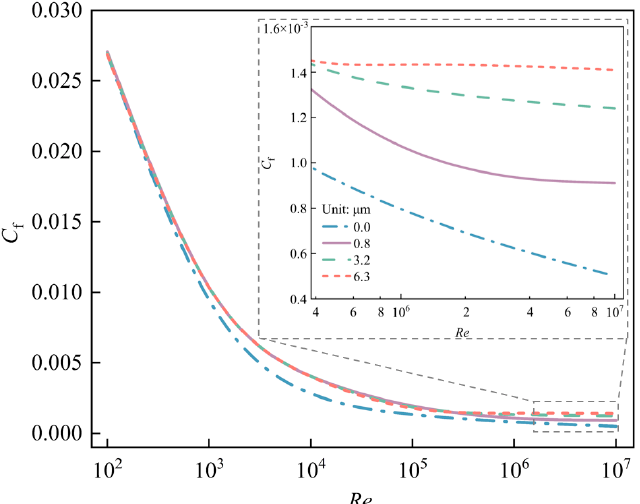
Figure 7. Skin friction coefficient C f versus Re for the geometry of Case I when Ra ranges from 0